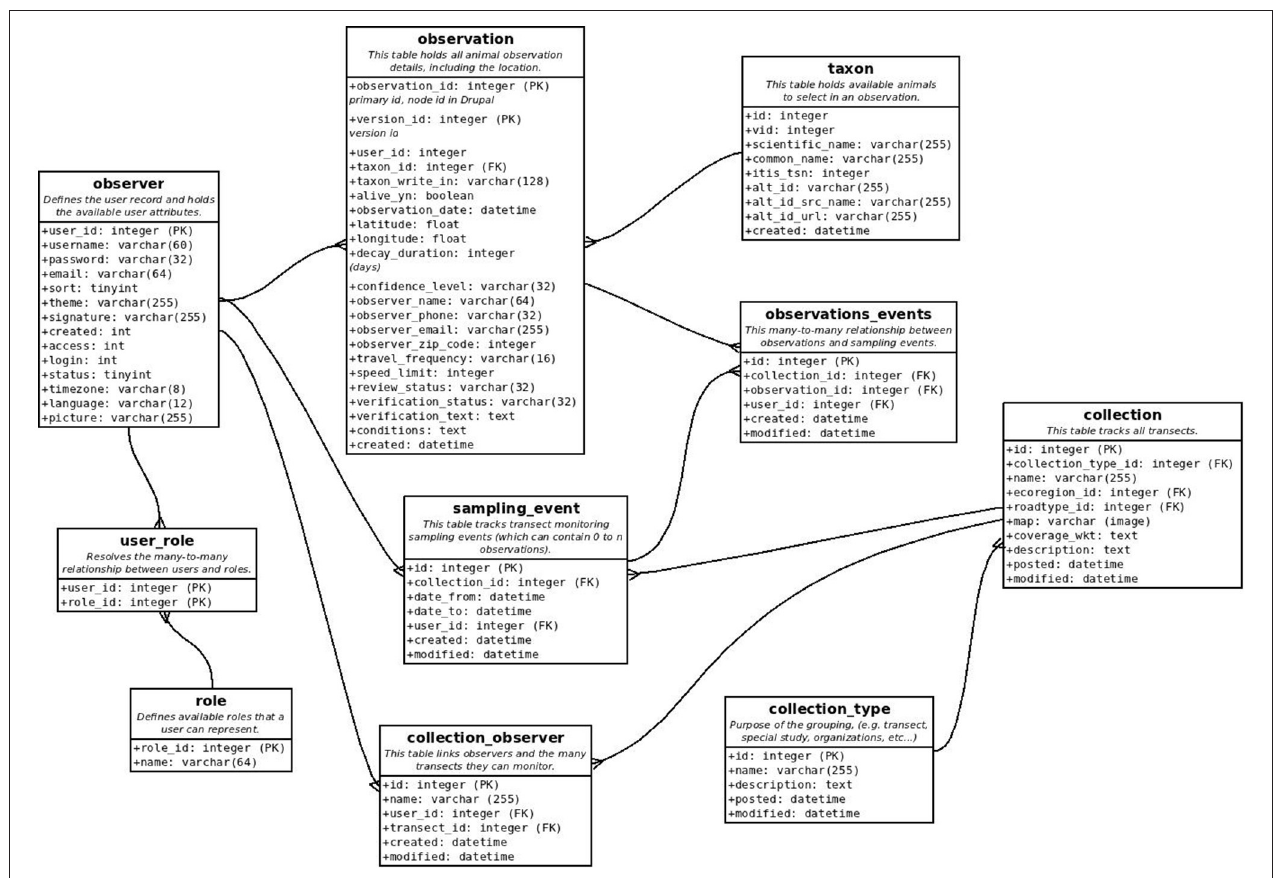
FIGURE 1 | Data model showing relationships among elements in the databases. Lines represent one-to-many relationships. Terms within each box describe the rules and information requirements for each element. Roles and permissions for observers are defined by the site administrators (authors) and are mutable. Controlled vocabularies and standardized ontologies for species are used for all